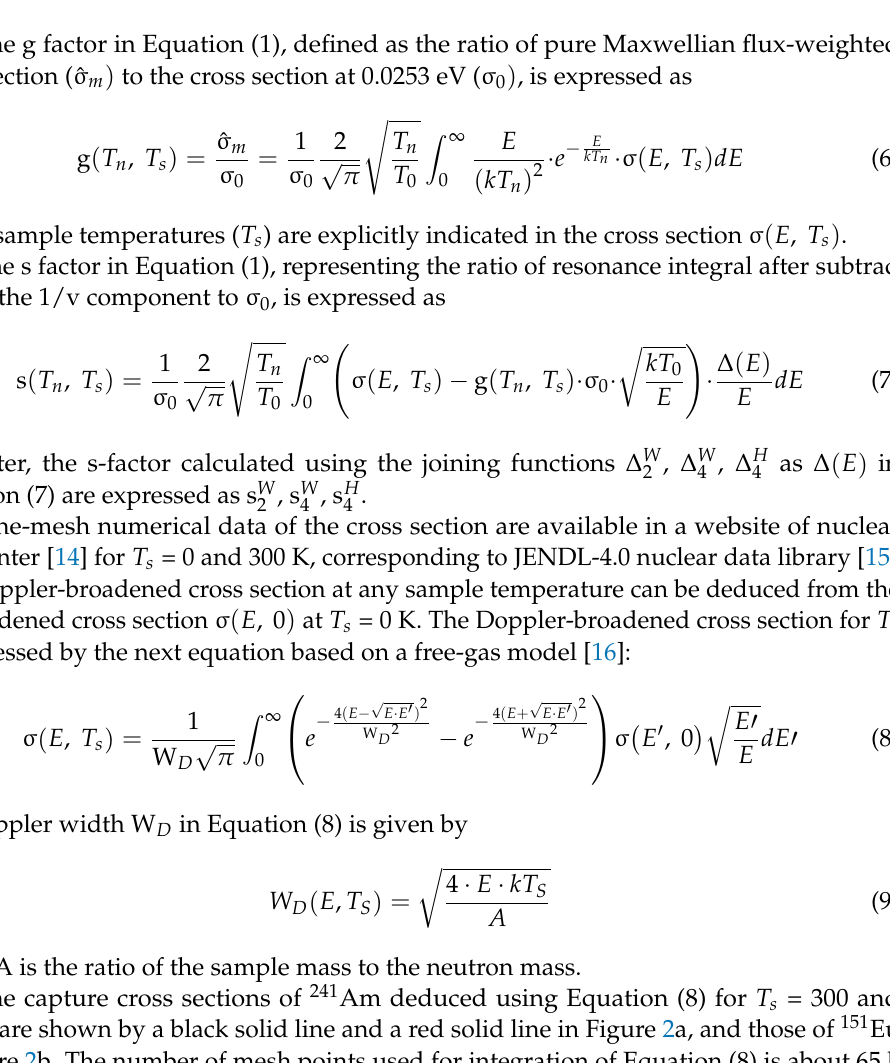
4 of 20 Figure 1. Joining functions 𝛥 2𝑊 (solid line), 𝛥 4𝑊 (dotted line), 𝛥 4𝐻 (dashed line) for neutron temperatures ( a ) 𝑇 𝑛 = 300 K; ( b ) 𝑇 𝑛 = 1000 K .